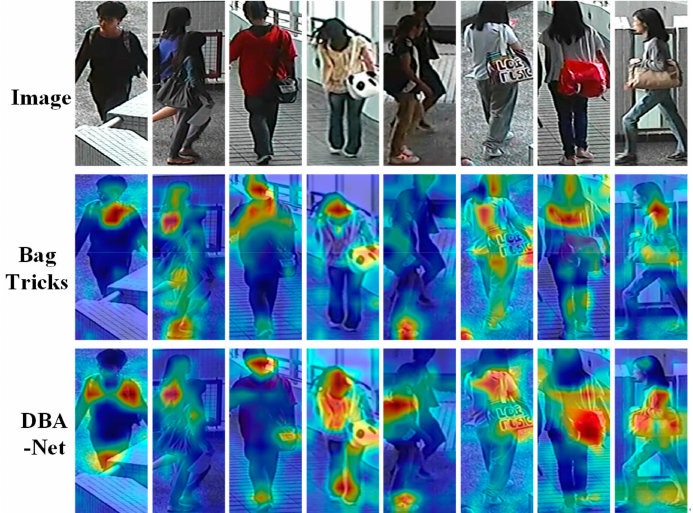
Figure 15. Heat maps of BagTricks and DBA-Net. Images in the same column share the same